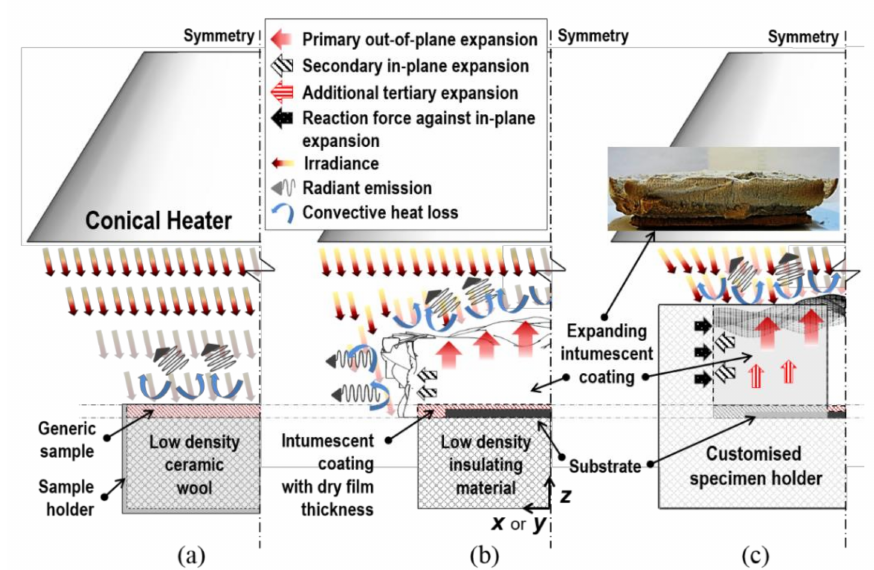
Figure 1. Schematics of thermal boundary conditions in cone calorimetry testing: ( a ) a typical material sample in flammability tests, ( b ) an intumescent-type specimen, and ( c ) an intumescent-type specimen with a customised